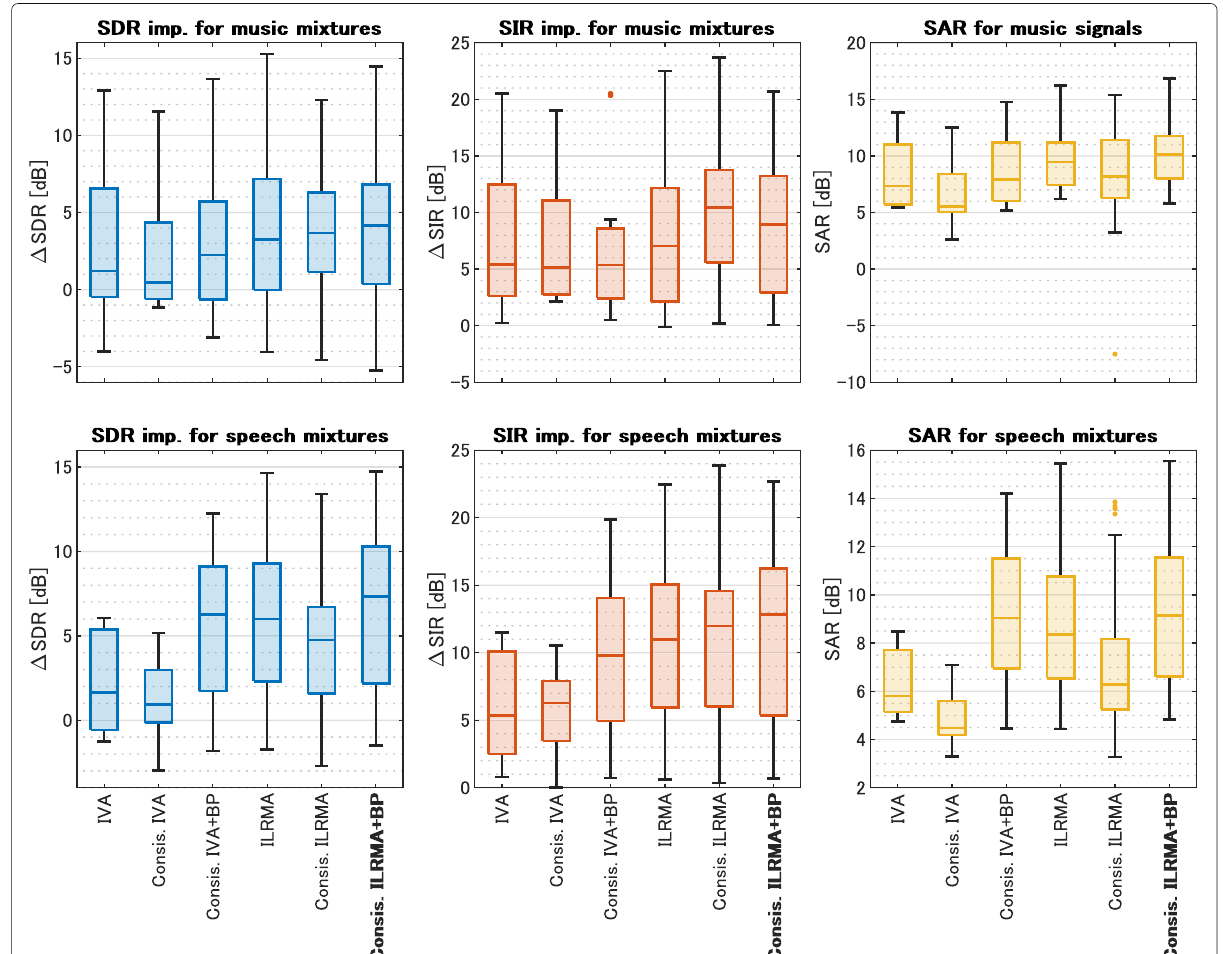
Fig. 10 SDR improvements (left column), SIR improvements (center column), and SAR (right column) for live-recorded music and speech mixtures, where STFT is performed using the 512-ms-long Hann window with 1/4 shifting. Top row shows the performances for music mixtures, and bottom row shows the performances for speech